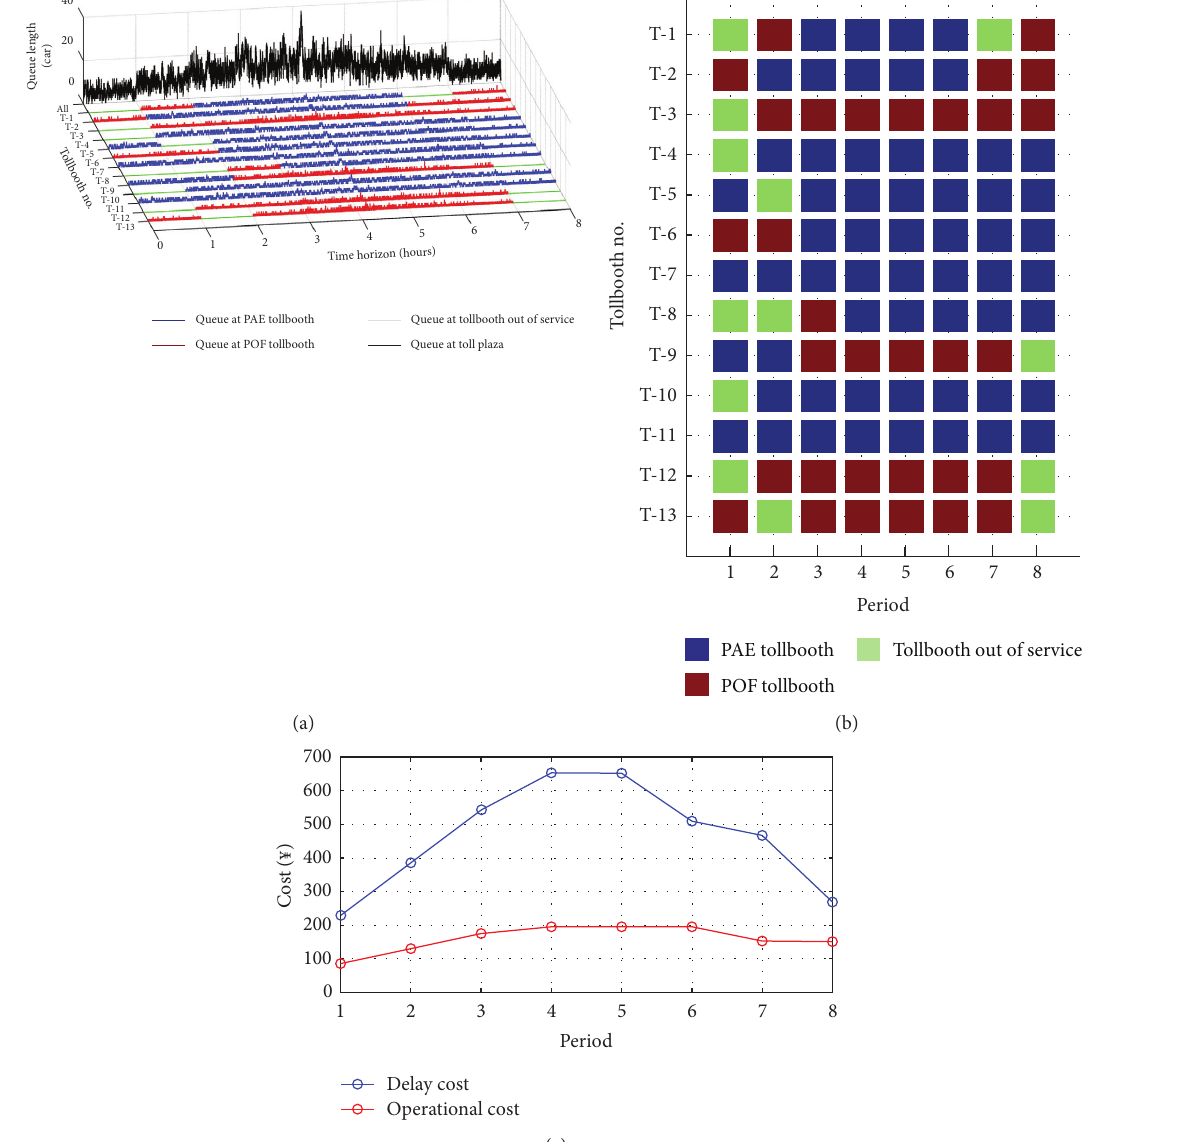
Figure 17: Recommended tollbooth operation scheme and its performance with weight of operational cost � 0.8. (a) Queue length evolution with time. (b) Best tollbooth operation scheme. (c) Costs in each period.